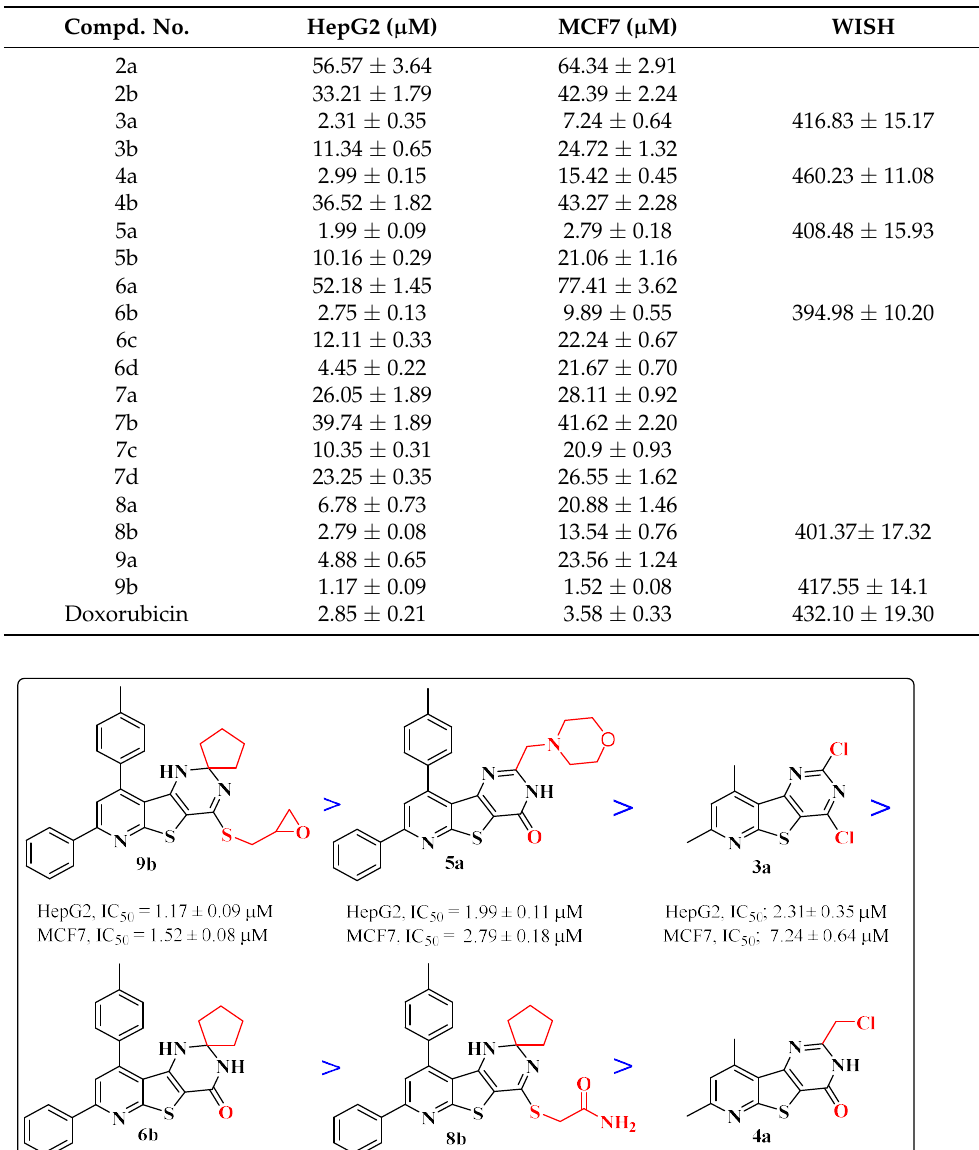
Table 3. Cytotoxic activities (IC 50 µ M) of the new compounds and doxorubicin against HepG2, MCF7 and WISH cells. Compd. No.